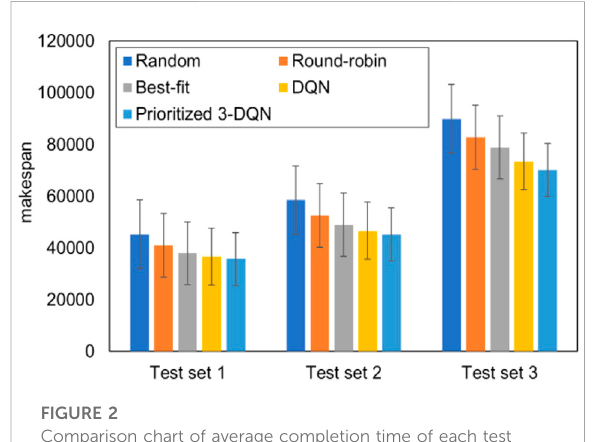
FIGURE 2 Comparison chart of average completion time of each test set with standard error.